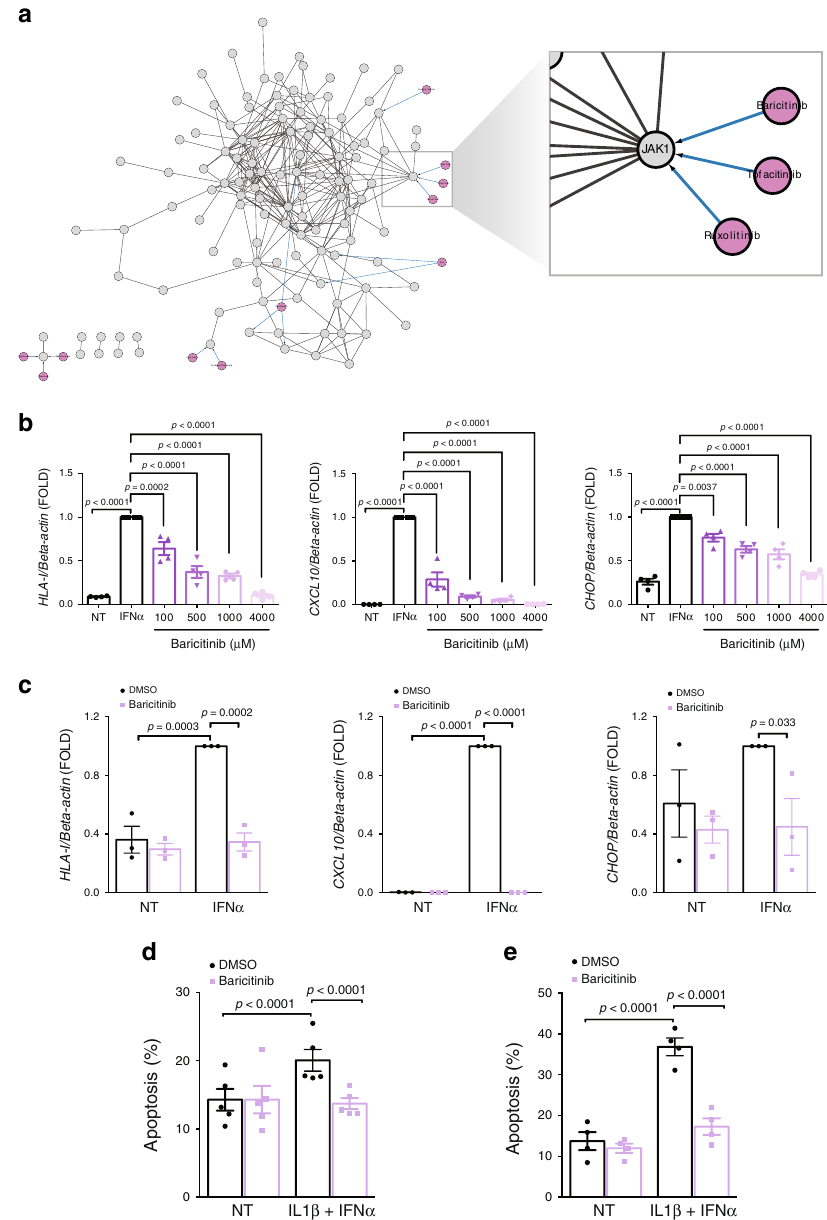
Fig. 8 Establishing JAK1 inhibition as protective mechanism against IFN α -mediated in fl ammation and apoptosis. a The PPI network of module #2 was integrated with the DrugBank repository 51 using the CyTargetLinker app 78 in Cytoscape. A higher magni fi cation on JAK1 is shown. b EndoC- β H1 cells were pretreated with DMSO (NT) or baricitinib at the indicated concentrations for 2 h. Cells were then left untreated (black bars), or treated with IFN α alone (white bars) without or with the presence of different concentrations of baricitinib (purple scale bars) for 24 h and mRNA expression of HLA class I (ABC), CXCL10 and CHOP (DDIT3) analyzed. The values were normalized by the housekeeping gene β -actin and then by the highest value of each experiment considered as 1 ( n = 4, mean ± SEM, ANOVA with Bonferroni correction for multiple comparisons). c Human islets were pretreated with baricitinib (4 μ M) or DMSO (vehicle) and then exposed or not to IFN α for 24 h in the presence or not of baricitinib. mRNA expression of HLA class I (ABC), CXCL10 and CHOP (DDIT3) was analyzed and values normalized by the housekeeping gene β -actin and then by the highest value of each experiment considered as 1. ( n = 3, mean ± SEM, ANOVA with Bonferroni correction for multiple comparisons). d , e EndoC- β H1 cells ( d ) and human islets ( e ) were pretreated with DMSO or baricitinib (4 µ M) for 2 h. Subsequently, cells were left untreated or treated with IFN α (2000 U/ml) + IL1 β (50 U/ml) in the absence or presence of baricitinib for 24 h. Cell viability was evaluated using nuclear dyes by two independent observers. ( d ( n = 5), e ( n = 4), mean ± SEM, ANOVA with Bonferroni correction for multiple comparisons). Source data are provided as a Source Data fi possible mechanism by which tissue-restricted autoimmune dis- be a source of potential neoantigens. Interestingly, IFN α -exposed eases might arise. Post-translational modi fi cations, alternative splicing and fi rst exon usage were induced by IFN α , likely and HLA-E, which may attenuate or delay the autoimmune expanding the repertoire of proteins and transcripts generated by assault. Finally, the present results provide a useful resource for beta cells in response to this in fl ammatory stimuli. This can also the discovery of compounds that may be used to reverse the